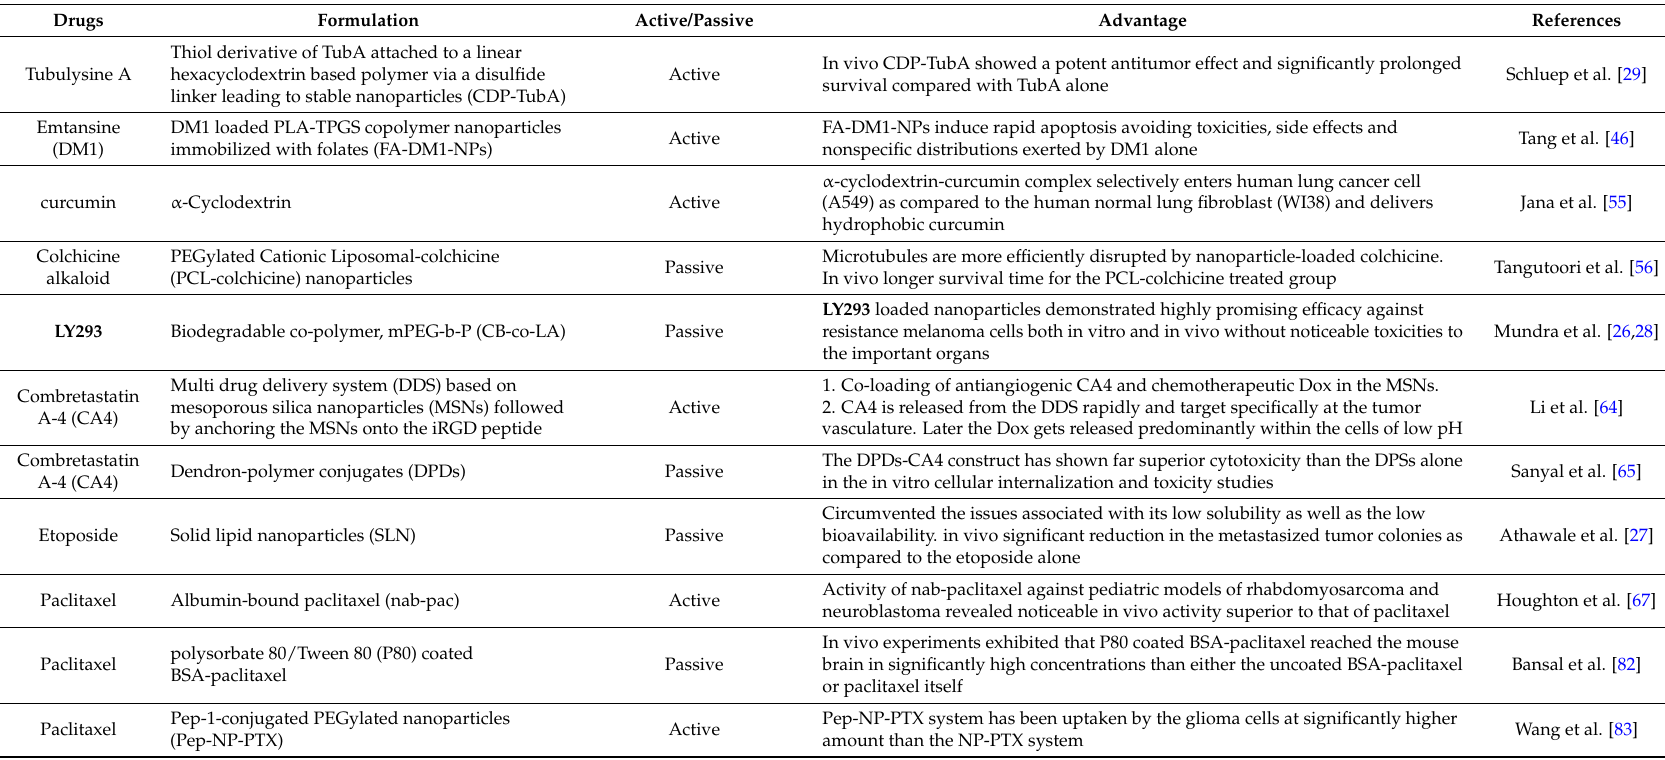
Table 1. Nanoparticle mediated delivery of tubulin